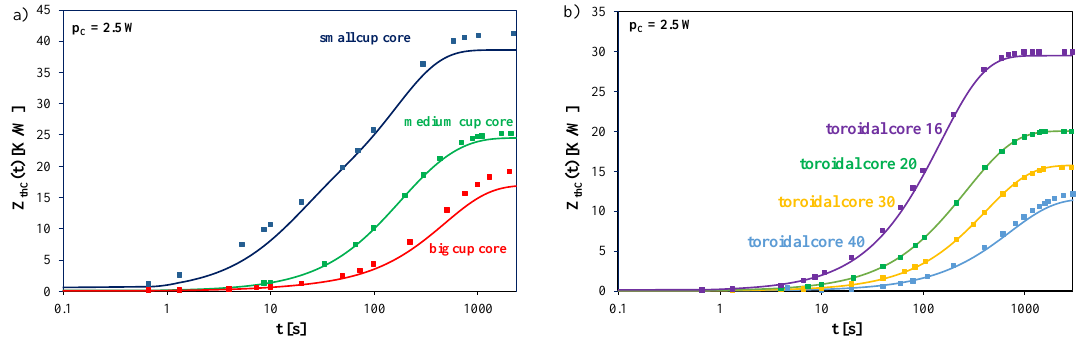
Figure 6. Measured and calculated waveforms of transient thermal impedance of the core for inductors with ( a ) cup and ( b ) toroidal cores of different dimensions. Figure 7. Measured and calculated waveforms of transient thermal impedance of the winding for inductors with ( a ) cup and ( b ) toroidal cores.